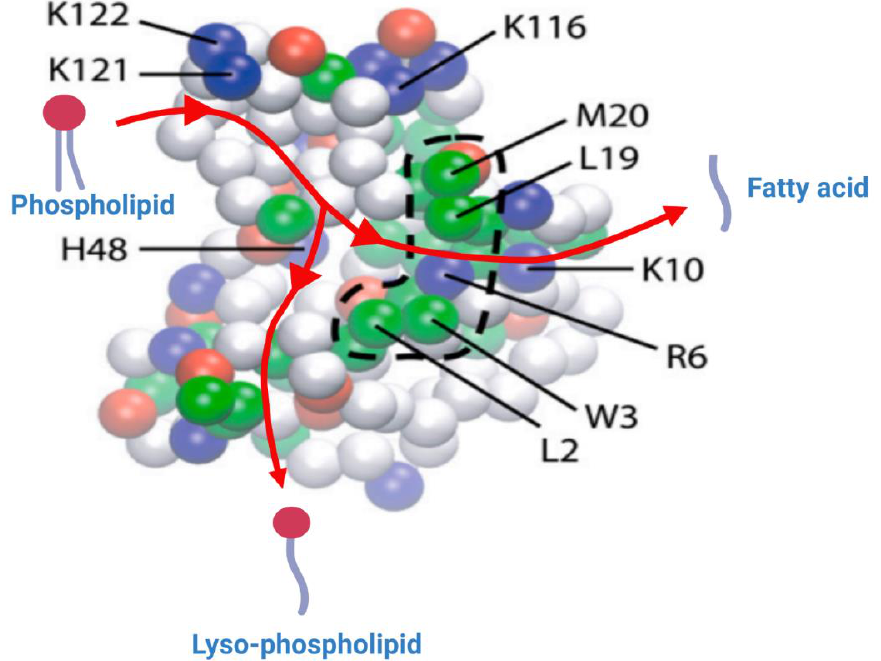
Figure 7. Representation of the bottom (inter)face of the sPLA2, which remains in contact with the lipid bilayer, generated through the CG simulation. The amino acid residues which remained deep in the bilayer are represented in strong colors, and the ones that are away from the bilayer are shown in faded colors. The hydrophobic, basic, acidic and polar residues are shown as green, blue, red and white spheres, respectively. The broken line delimiting the cluster of hydrophobic residues (Trp-3, Leu-19, Met-20) highlights the key residues believed to anchor the sPLA2 into the lipid bilayer. The basic residues (Arg-6, Lys-10, Lys-116, Lys-121 and Lys-122) form electrostatic interactions with the phosphate group and with the carbonyl group of the lipid substrate. Reprinted/adapted with permission from [22]. Copyright 2008, Elsevier.